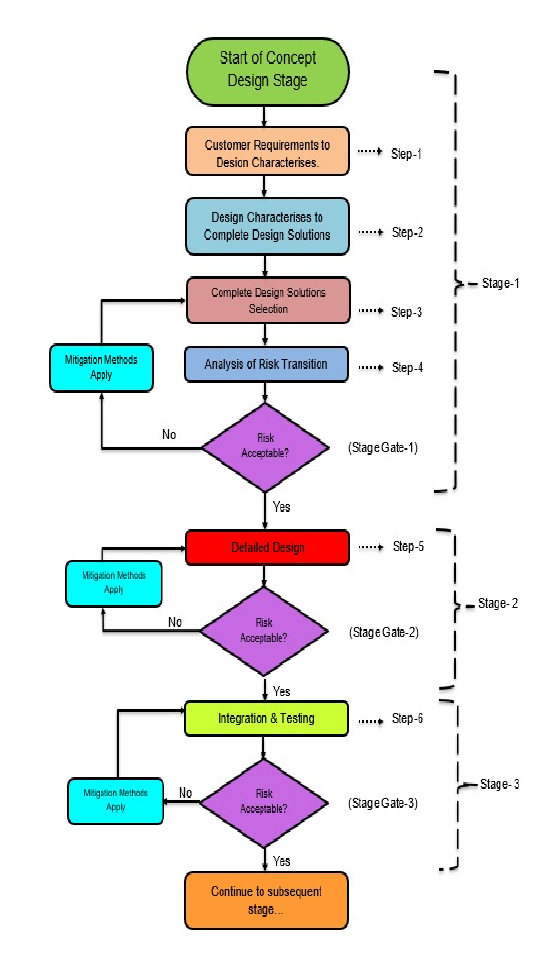
Fig.1. Flowchart of the